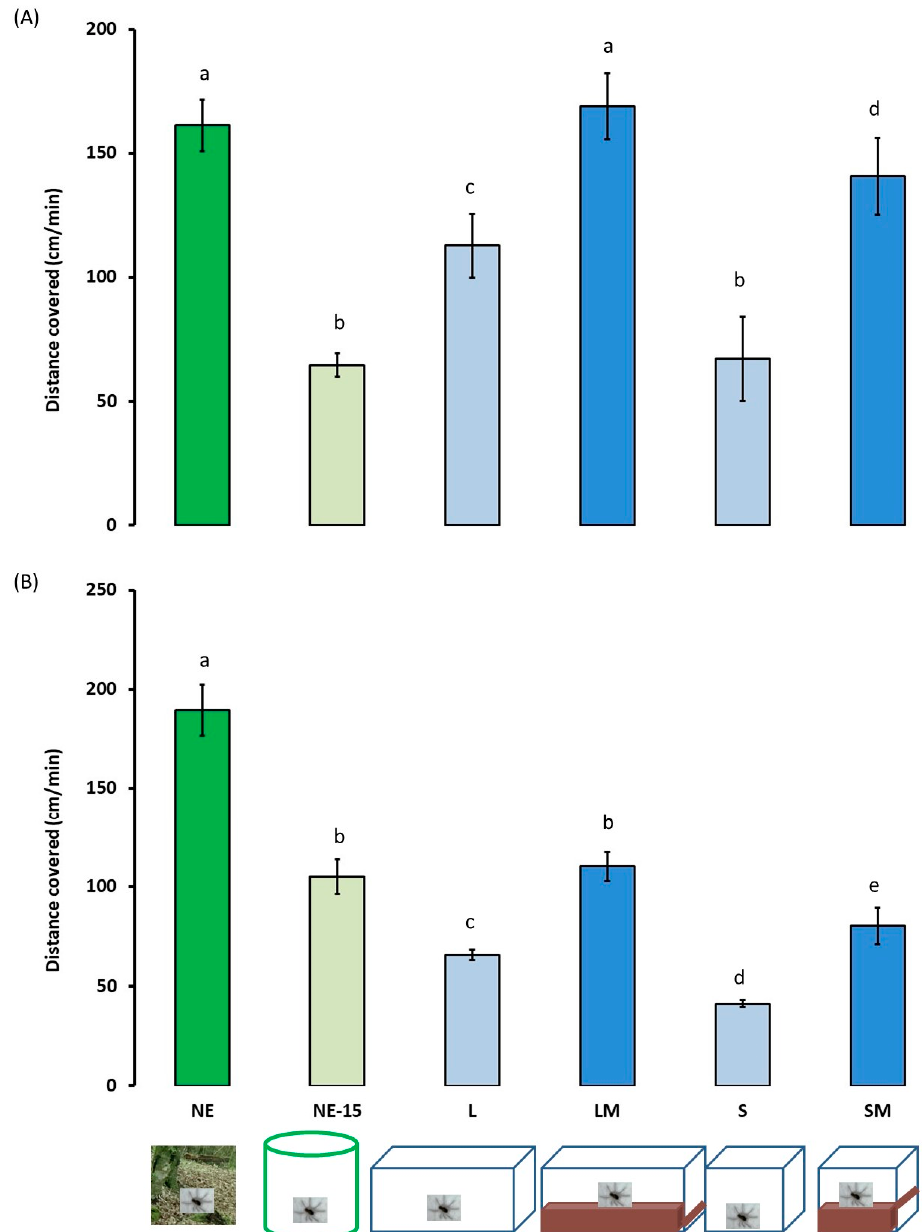
Figure 8. Exploratory activity ±95% confidence intervals (expressed in distances covered, cm/min) of adult female ( A ) and male ( B ) Pardosa saltans in a radial arm maze in relation to the environment where they developed: (NE) in their natural environment and tested 2–3 h after capture; (NE-15)